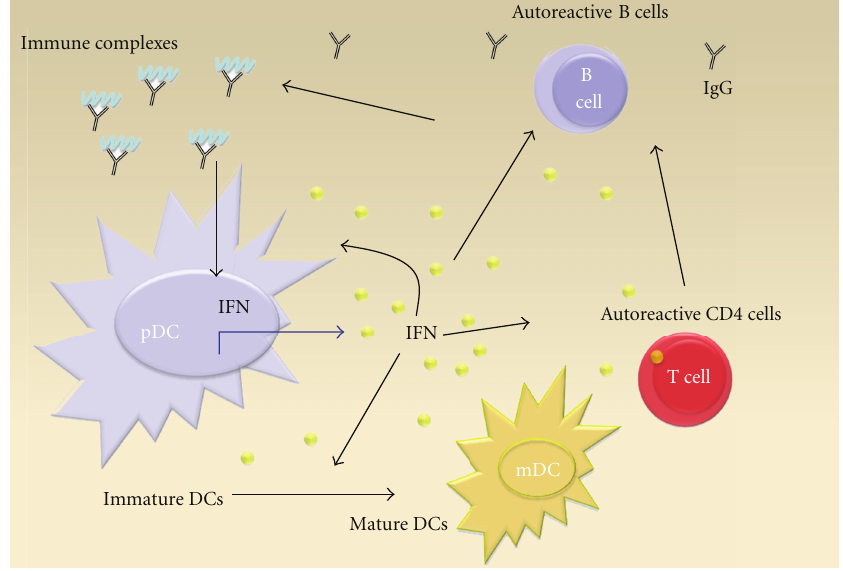
Figure 1: The vicious circle of IFN signaling in SLE: ICs bind to Fc gamma RII receptors on pDCs and reach the endosomes where they are recognized by TLRs. TLRs transduce signals to the nucleus which induce transcription of IFN. IFN secretion enhances expression of its own receptor on pDCs, mDCs, and monocytes. Furthermore, IFN promotes maturation of DCs which leads to disruption of peripheral tolerance and activation of autoreactive CD4 T helper cells. The appearance of autoreactive CD4 T cells is further amplified by upregulation of CD80 and CD86 on APCs. This results in enhanced B cell help by autoreactive CD4 cells, which is again sustained by an upregulation of BAFF. The increased formation of autoreactive B cells triggers appearance of ICs and further IFN release.